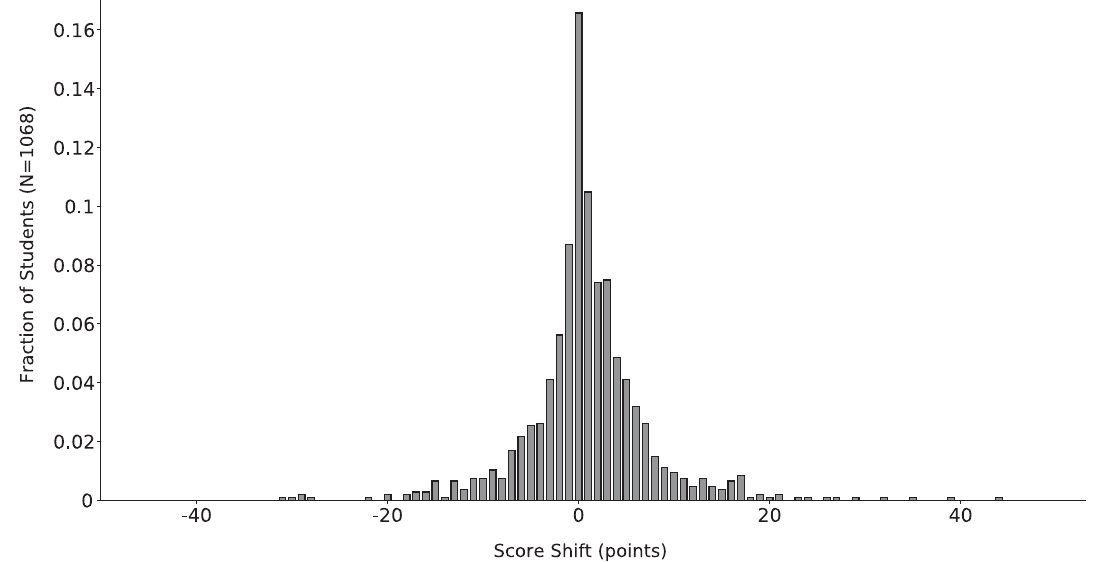
FIG. 1. Distribution of the shift in students ’ raw FMCE scores between PHYS I and PHYS II. Bins are 1 point in size and the bin is centered on the value of the shift. Positive indicates the student ’ s score was higher in PHYS II than in PHYS I. Note the distribution is not normal due to the large peak at a score shift of zero (Skewness-Kurtosis test, p < 0 . 001 ). There are 47 questions on the FMCE resulting in a maximum possible shift of 47 points in either